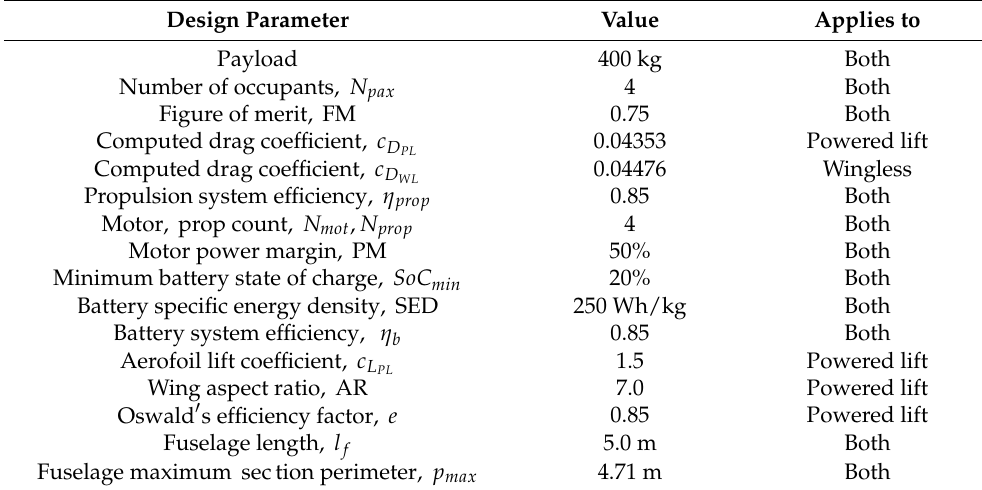
Table 2. Powered lift and wingless eVTOL aircraft design parameters for the sizing study.